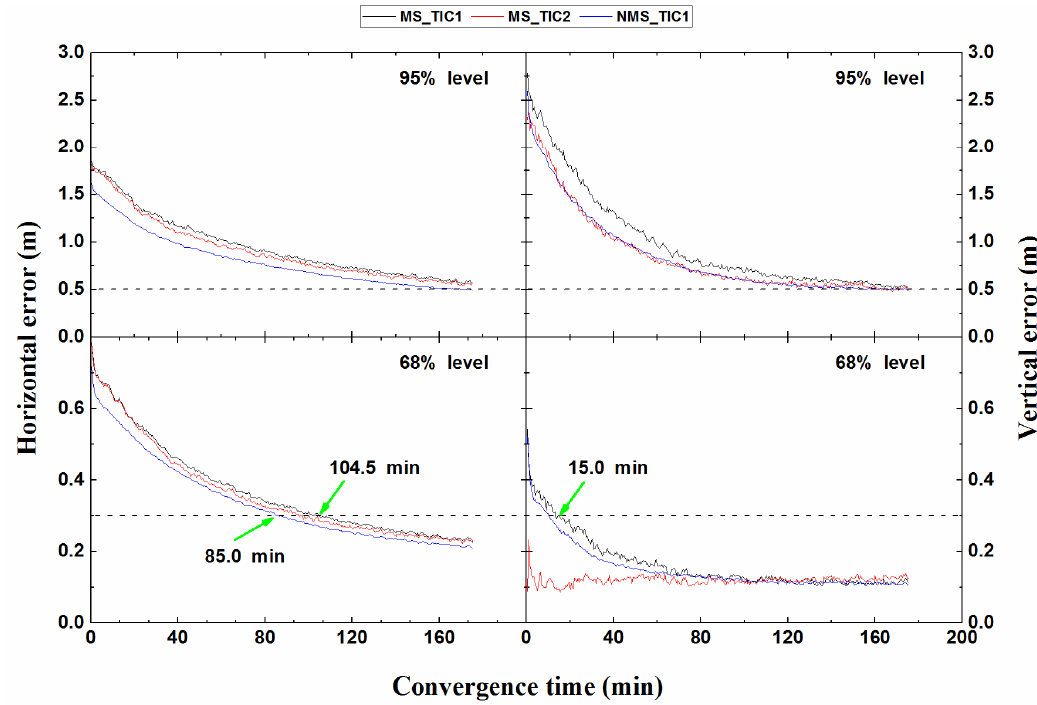
Figure 6. The GPS kinematic SF PPP convergence performance in different constraint schemes during the MS and NMS periods.